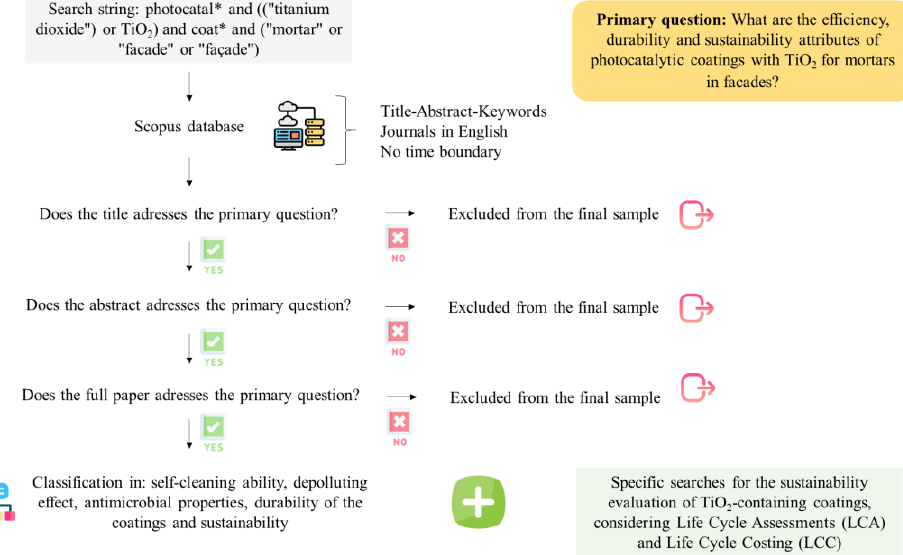
Figure 1. Protocol applied to conduct the literature review. This flowchart has been designed using resources from Flaticon.com (Eucalyp, Freepik, Icon mania and Vectors Market).